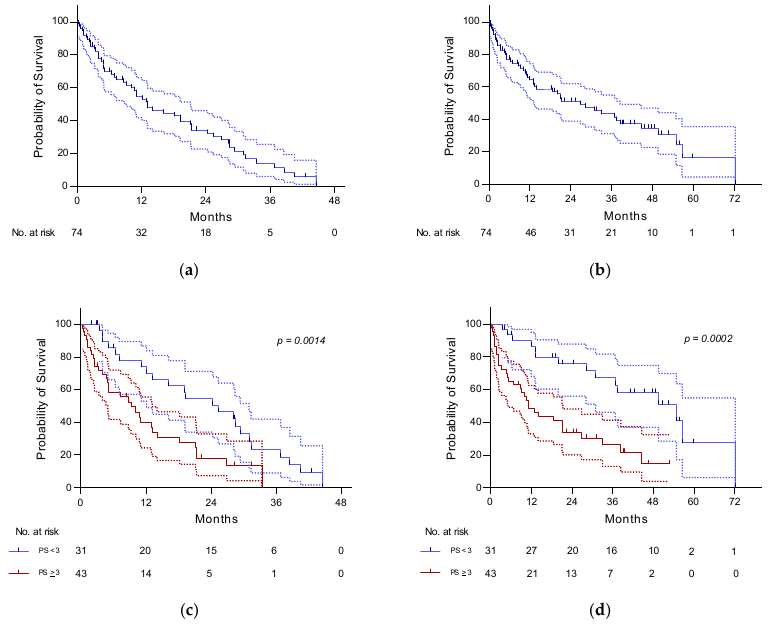
Figure 1. Progression-free survival ( a ) and overall survival ( b ) of the whole cohort. Progression-free survival ( c ) and Overall survival ( d ) in the group of patients with ECOG PS < 3 (blue line) and >3 (red line).